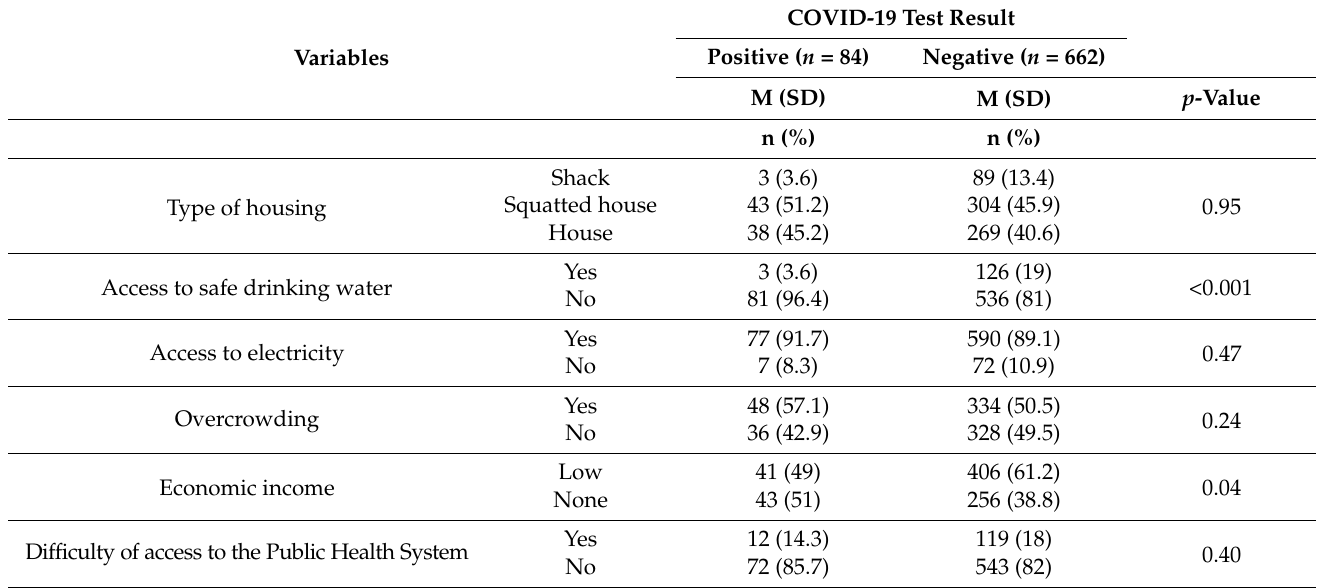
Table 2. Analysis of the social determinants of health among COVID-19 positive and negative individuals.